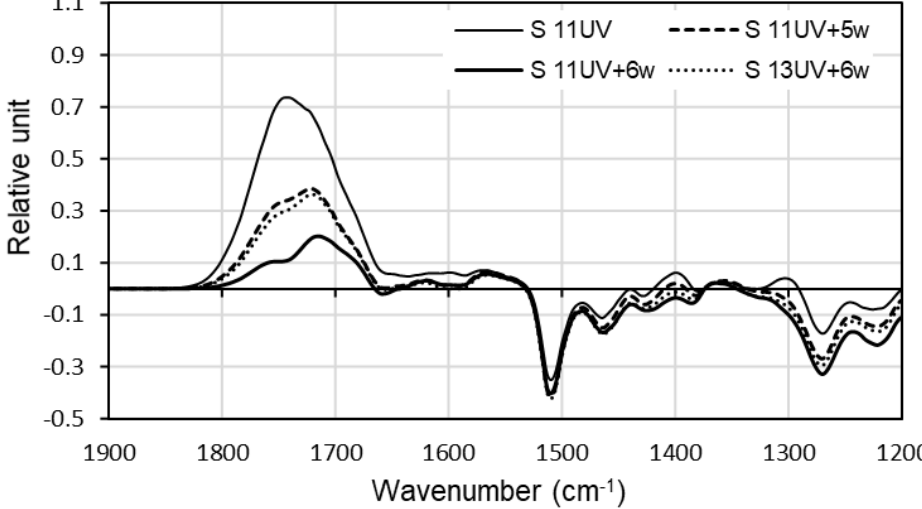
Figure 6. Difference FTIR spectra of spruce (S). 11 UV = eleven-day UV irradiation; xUV + yw is an abbreviation where x is the extent of UV irradiation, and y is the extent of water leaching in days.